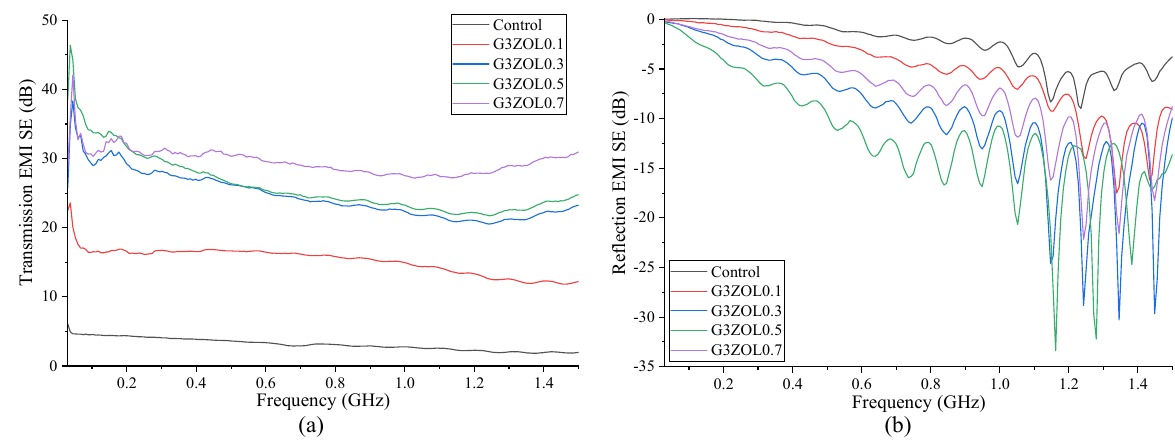
Figure 6. ( a ) Transmission EMI SE containing 3 mm CF; ( b ) reflection EMI SE containing 3 mm